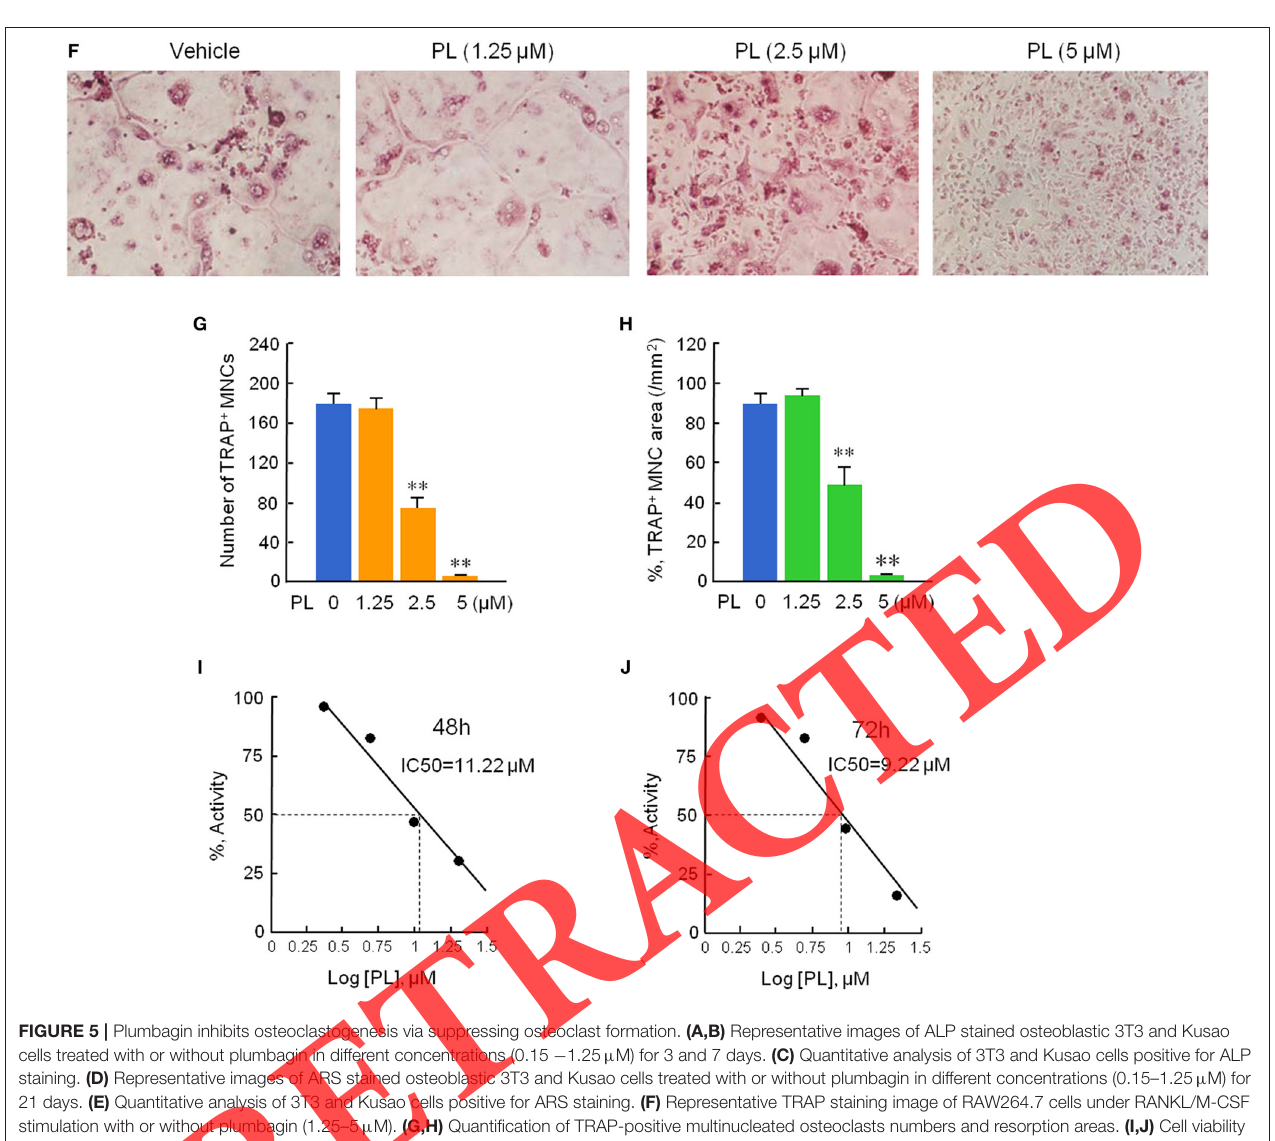
FIGURE 5 | Plumbagin inhibits osteoclastogenesis via suppressing osteoclast formation. (A,B) Representative images of ALP stained osteoblastic 3T3 and Kusao cells treated with or without plumbagin in different concentrations (0.15 − 1.25 µ M) for 3 and 7 days. (C) Quantitative analysis of 3T3 and Kusao cells positive for ALP staining. (D) Representative images of ARS stained osteoblastic 3T3 and Kusao cells treated with or without plumbagin in different concentrations (0.15–1.25 µ M) for 21 days. (E) Quantitative analysis of 3T3 and Kusao cells positive for ARS staining. (F) Representative TRAP staining image of RAW264.7 cells under RANKL/M-CSF stimulation with or without plumbagin (1.25–5 µ M). (G,H) Quantification of TRAP-positive multinucleated osteoclasts numbers and resorption areas. (I,J) Cell viability assessment of RAW264.7 cells treated with plumbagin (2.5–20 µ M) for 48h and 72h. The IC50 values in RAW264.7 cells treated with plumbagin for 48h and 72h is 11.22 and 9.22 µ M, respectively. Quantitative results are presented as mean ± SEM, and n = 5/group. ## , **, && , P < 0.01 versus control in (C) and (E) . **, P < 0.01 versus plumbagin 0 µ M group in (G) and (H)